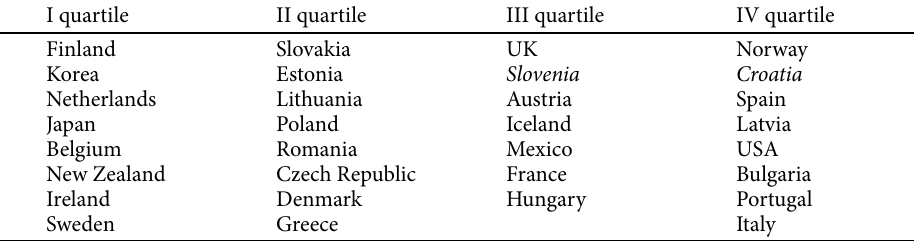
Table 4. The relative efficiency of secondary education system in selected OECD and EU (plus Croatia) countries (Distribution by quartiles of the ranking of efficiency scores in all four models) I